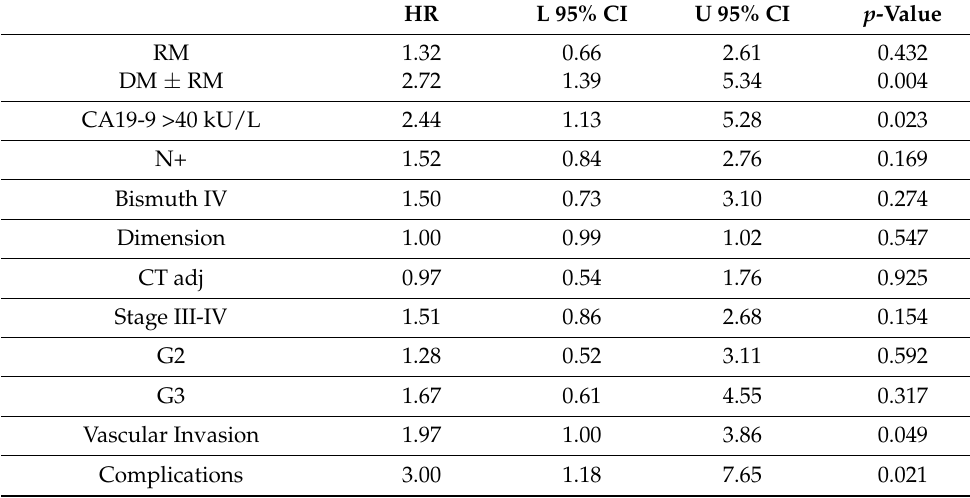
Table 7. Univariate analysis for recurrence prognostic factors.